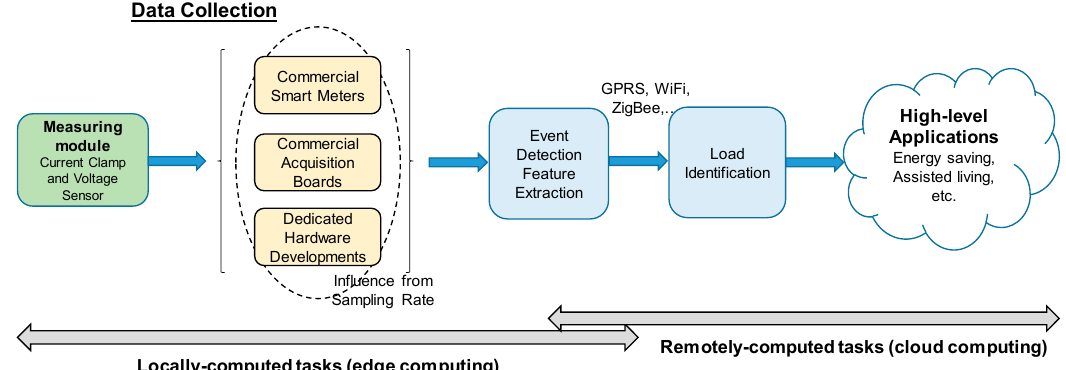
Figure2. Figure 2. General view of the different aspects involved in the process of data collection for NILM applications.